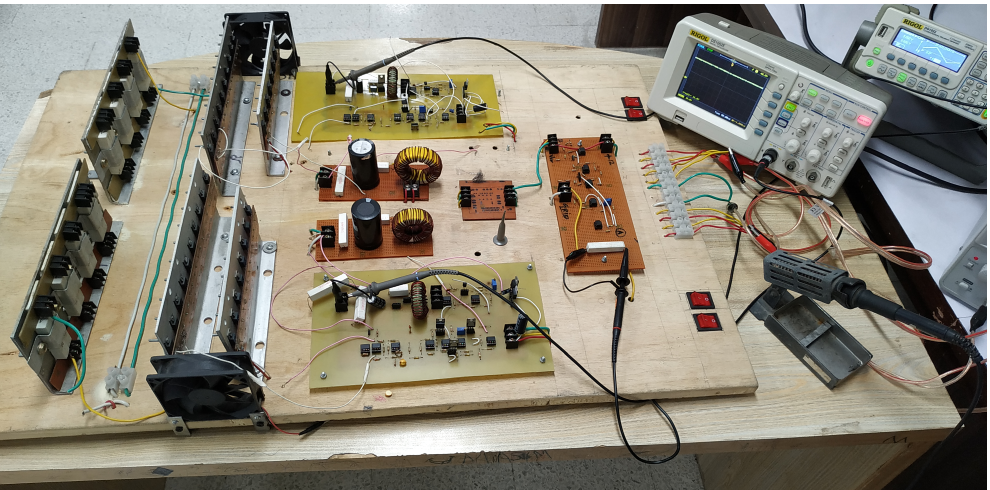
Figure 4. Experimental setup of the proposed controller.